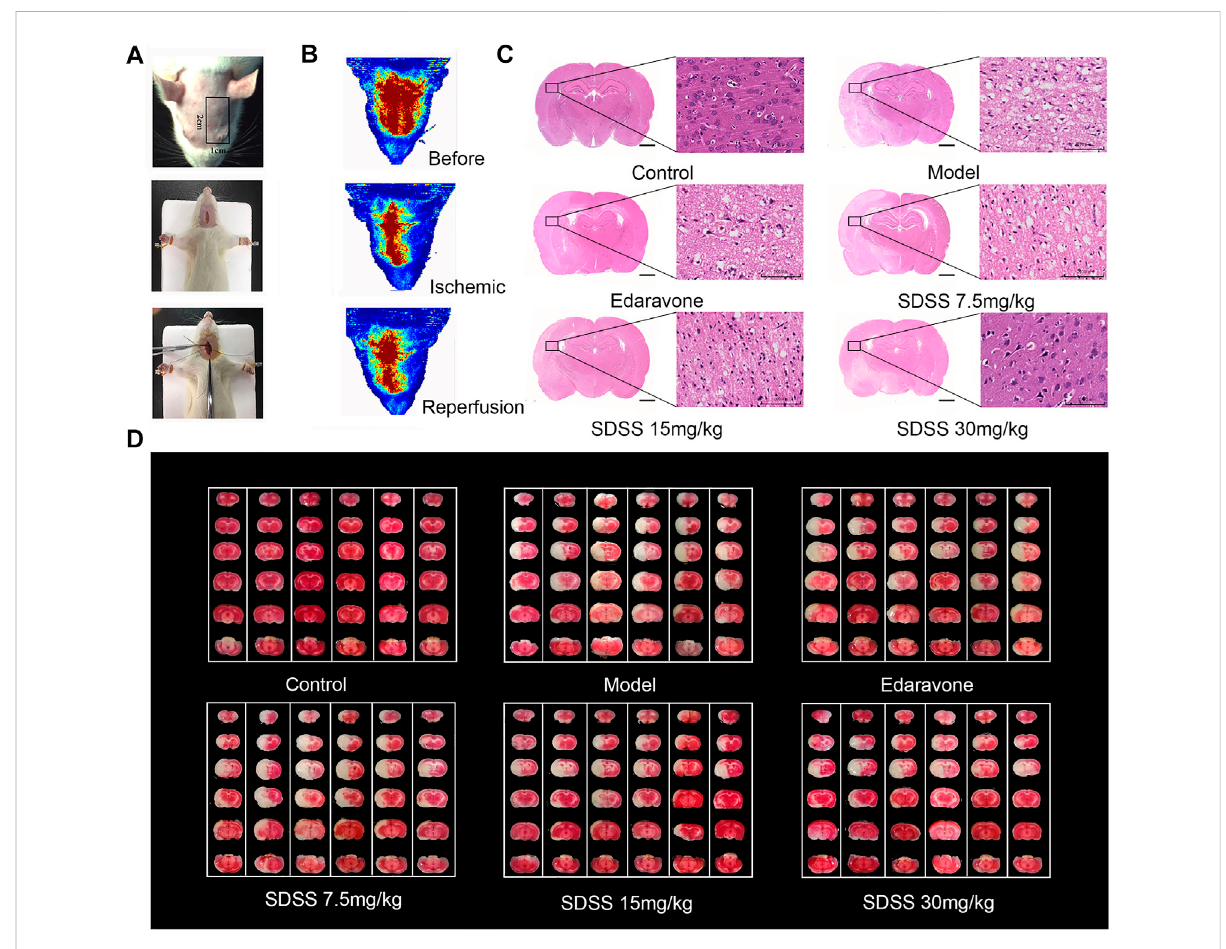
FIGURE 7 SDSSalleviatesCIRIinrats. (A) OperationproceduresfortheCIRImodel.The fi rstrowshowsthedetectionareaofthebloodstream.Thesecond and third rows show the insertion of intraluminal thread. (B) Representations of rheoencephalograms of rats in healthy, ischemic, and reperfusion stages. (C) HE staining of the brain tissue samples in control, ischemia/reperfusion model, and SDSS cohorts. (D) TTC staining of whole brain tissue after ischemia/reperfusion in each group. The white areas represent necrosis. For all HE and TTC staining experiments, each lane contains one whole brain tissue sample, which has been cut to 6 pieces in order to do TTC staining. Number of replicates =